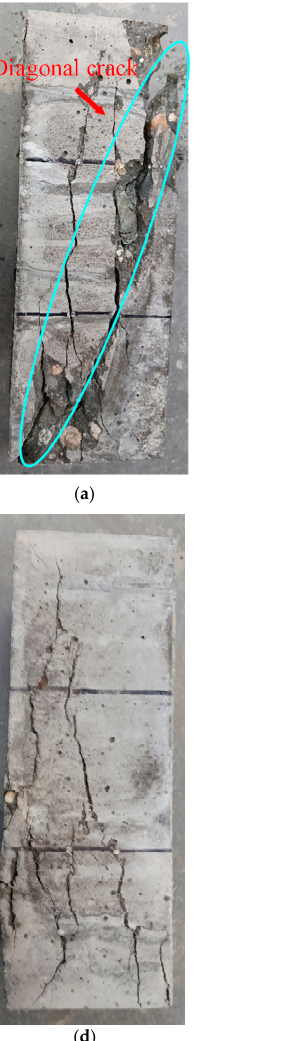
Figure 15. Comparison between numerical and test results: f c .